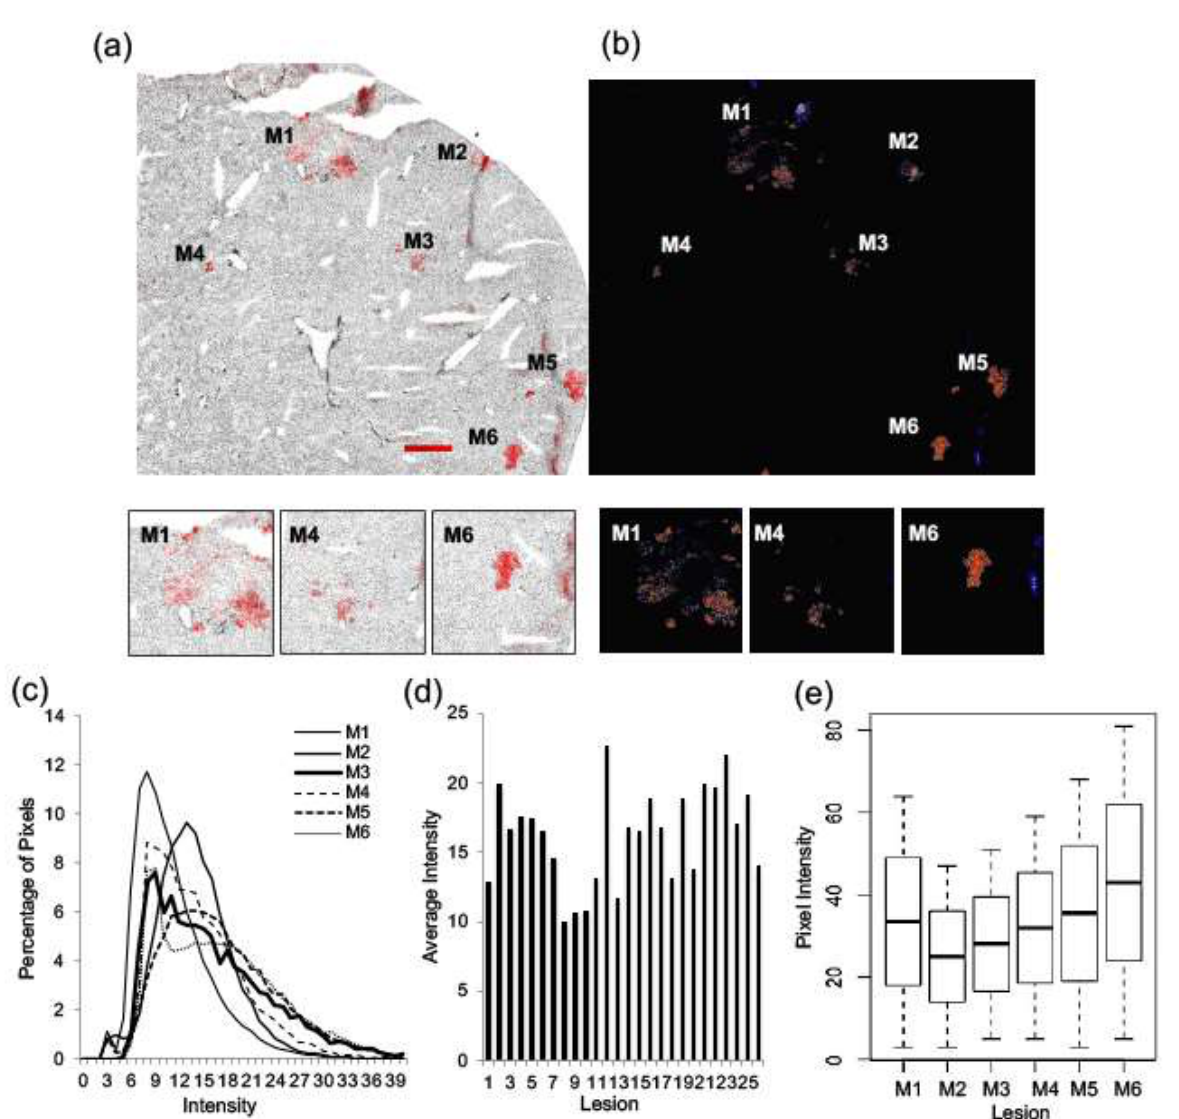
Figure 4. Significant inter-metastatic heterogeneity is seen for Her2/neu expression across liver lesions. Sections of liver tissue were probed for Her2/neu expression and imaged for Her2/neu (red) and Hoechst (grey) ( n = 3). A representative image of a section of liver tissue is shown ( a ), and metastatic lesions are identified as M1 through to M6. Selected lesions that represent high expression levels (M6) and low expression levels (M1 and M4) are shown. A heat map was generated from the greyscale image of Her2/neu fluorescence ( b ). Her2/neu expression was examined by looking at the distribution of pixels across intensity levels from 0 to 255 for each lesion within the tissue ( c ). The average pixel intensity for each lesion within 3 liver samples from three animals was also plotted ( d ). Boxplots were used to illustrate the distribution of pixels across intensity levels for each lesion within one liver section, and a Kruskal–Wallis test provided a statistically significant p -value (<0.0001) ( e ). Bar = 250 µm.